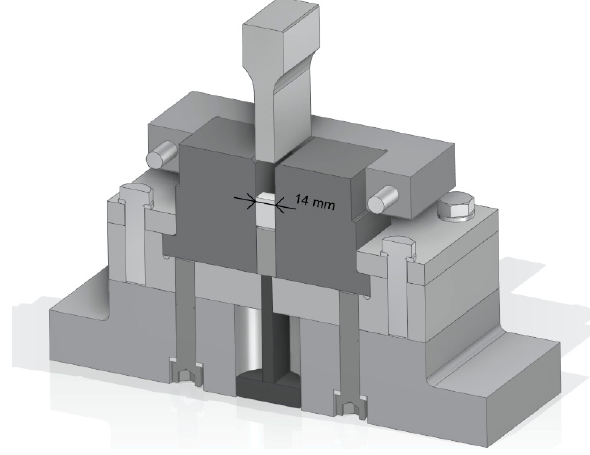
Figure 4. Die for plane strain compression [31].